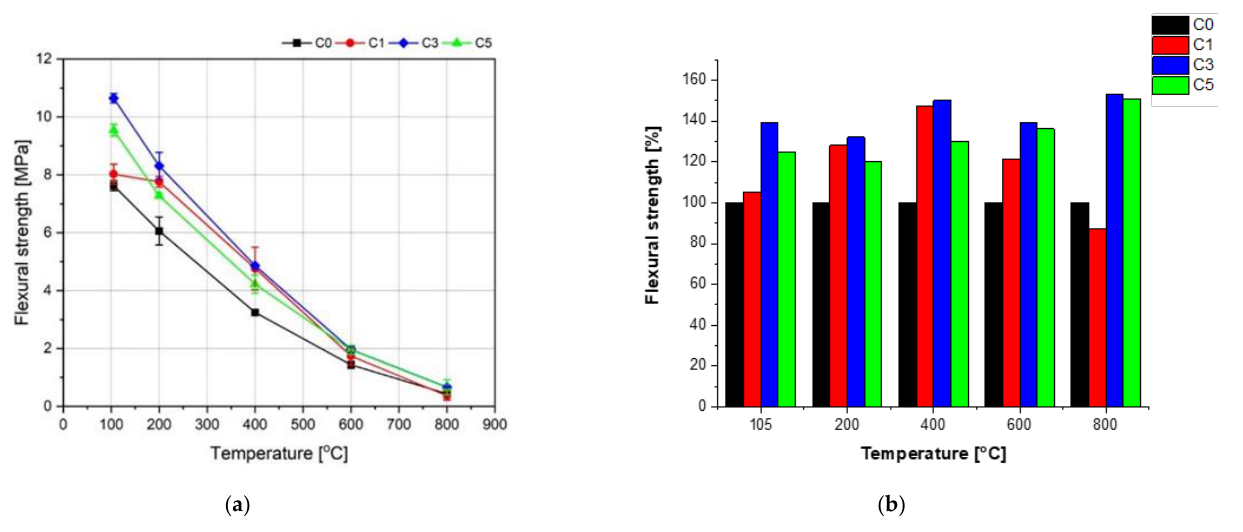
Figure 13. Influence of NS admixture on the flexural strength as a function of heating temperature ( a ) and analysis of flexural strength changes for the concrete specimens containing NS in relation to the concrete C0 without NS ( b ).